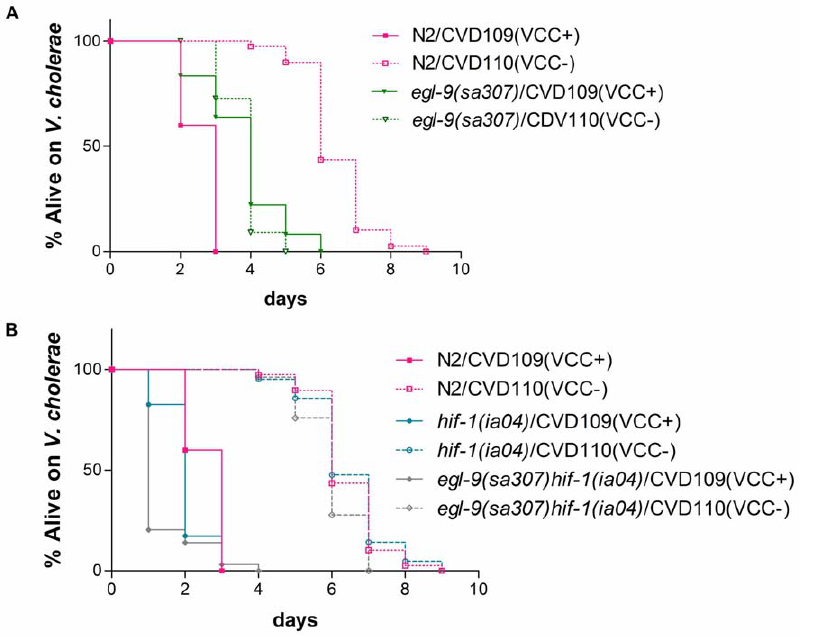
Figure 3. egl-9 mutation confers resistance to V.cholerae VCC. (A) The survival of wild-type N2 and egl-9(sa307) mutant animals on V. cholerae CVD109(VCC + ) and CVD110(VCC 2 ) are shown. (B) The survival of wild-type N2, hif-1(ia04) , and egl-9(sa307) hif-1(ia04) mutant animals on V. cholerae CVD109(VCC + ) and CVD110(VCC 2 ) are shown. Quantitative data and statistical analyses for the representative experiment shown here are included in Table 2. Data for two other independent repetitions of the experiment are shown in Table